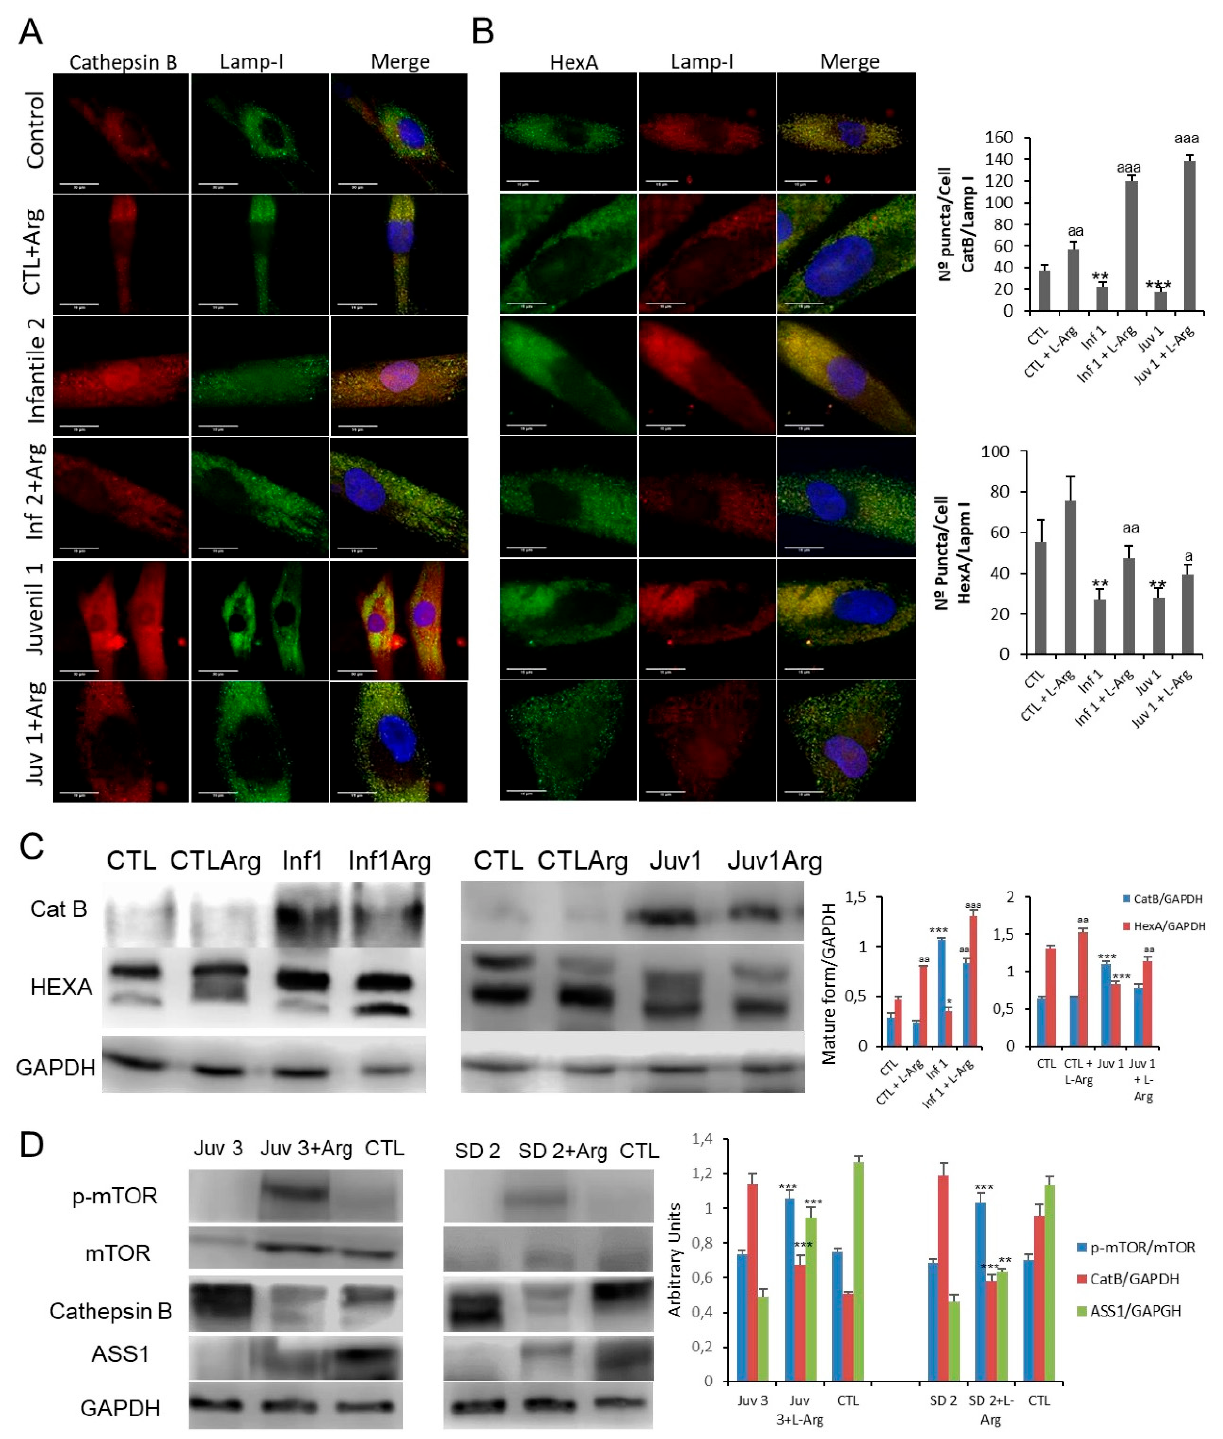
Figure 7. ( A , B ). Immunofluorescence of CatB and HexA in control and Sandhoff disease fibroblasts and quantification after L-arginine treatment. ( C ). Expression of CatB and HexA protein were determined in control and representative Tay–Sachs fibroblast cultures after L-arginine treatment in vivo. ( D ). Expression of mTOR, CatB, and ASS1 (arginosuccinate synthetase) proteins was determined in peripheral blood mononuclear cells obtained from a patient with juvenile Tay–Sachs disease and a patient with juvenile Sandoff disease after oral L-arginine treatment. Data represent the mean ± SD of three separate experiments.* p < 0.05; ** p < 0.01; *** p < 0.001 between control and Tay–Sachs patients; a p < 0.05; aa p < 0.01; aaa p < 0.001 between non-treated and treated cells.